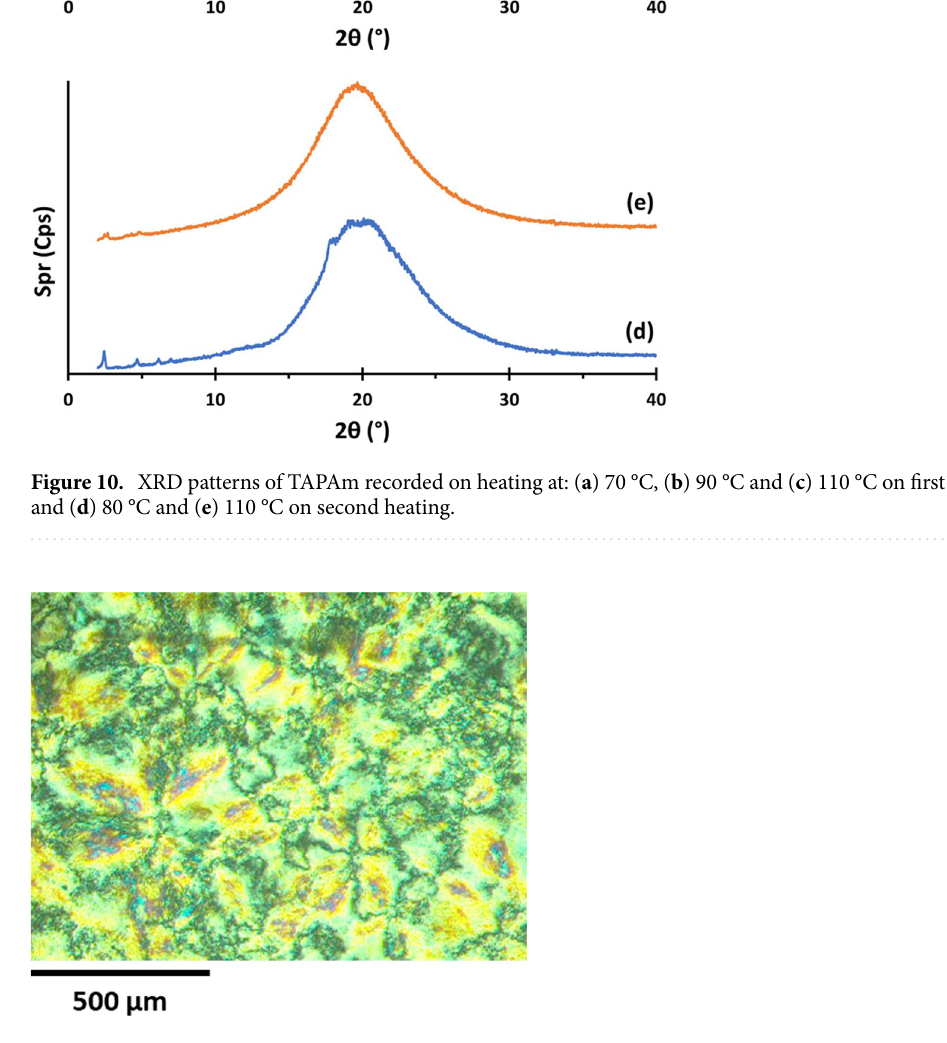
Figure 11. Optical micrographs between crossed polars of TAPAm recorded during the first heating at 90